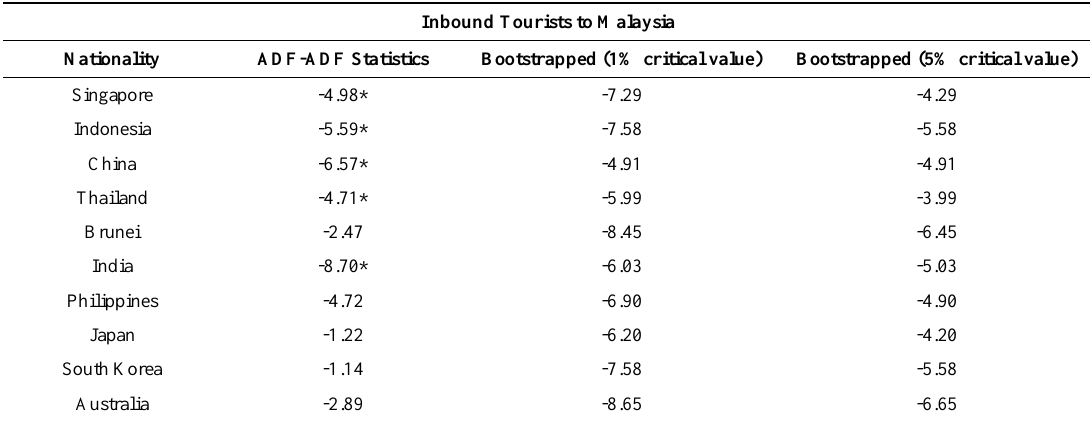
Table 6. Results of the ARNN-ADF